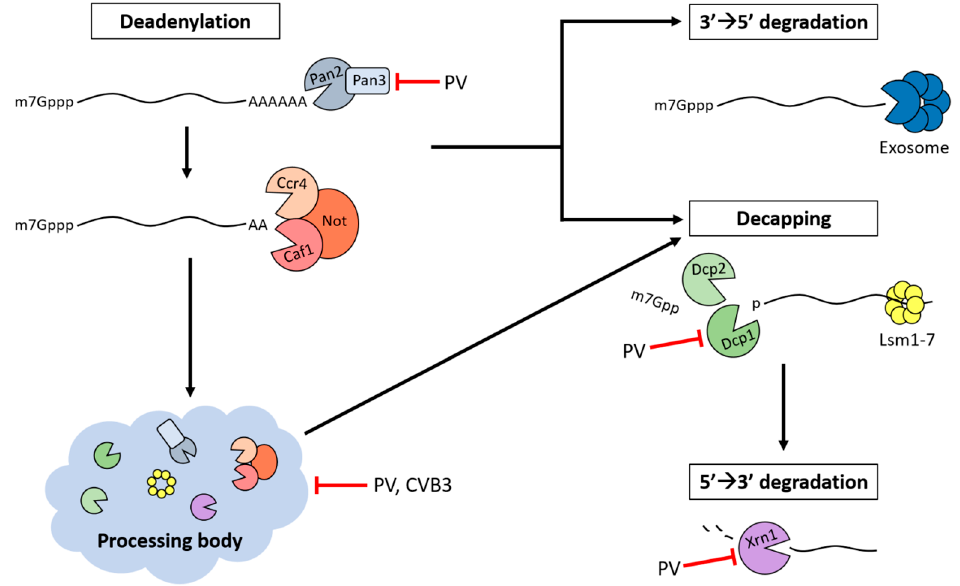
Figure 3. Inhibition of PBs and mRNA decay proteins during picornavirus infection. Deadenylation, decapping, and 5 ′ → 3 ′ RNA degradation machinery are targeted during poliovirus (PV) and coxsackievirus B3 (CVB3) infection. The localization of non ‐ translating RNAs and mRNA decay proteins in PBs indicate that these RNA granules may be involved in 5 ′ → 3 ′ mRNA decay. PBs are dispersed during poliovirus and CVB3 infection, thereby disrupting their possible contribution to vRNA degradation. During poliovirus infection, Pan3 and Dcp1a are cleaved by 3C proteinase and Xrn1 is degraded by a proteasome ‐ dependent mechanism.